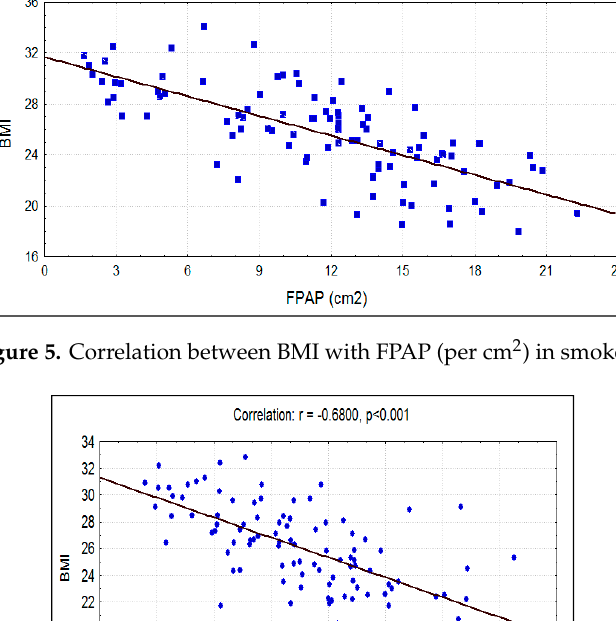
. . 2 ) in nonsmokers.